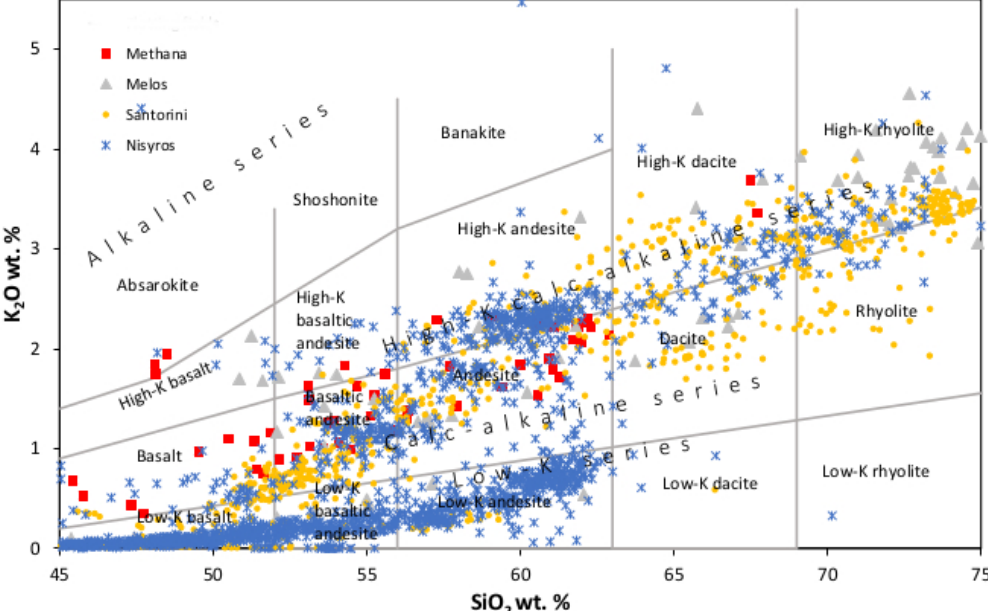
Figure 5. K2O vs. SiO2 diagram. Figure 5. K 2 O vs. SiO 2